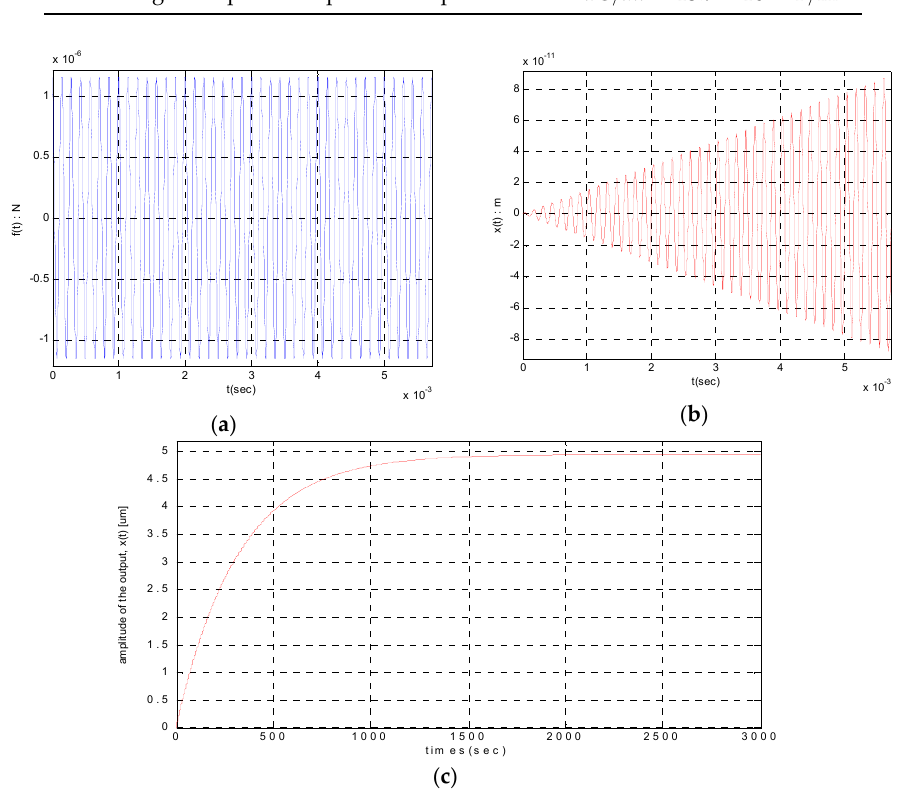
Figure 1. The displacement output by continuous harmonic excitation: ( a ) The control force input (N); ( b ) The displacement output ( t ď 40 ¨ 2 π ω s); ( c ) The displacement output ( t ď 3000 In Equation (5), as